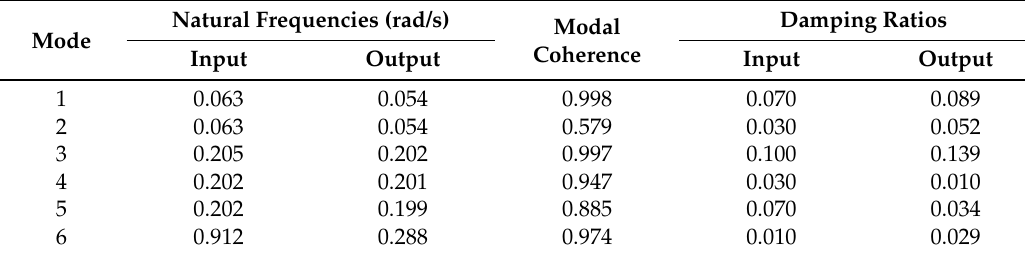
Table 9. Evaluation of FDD efficiency for the fourth